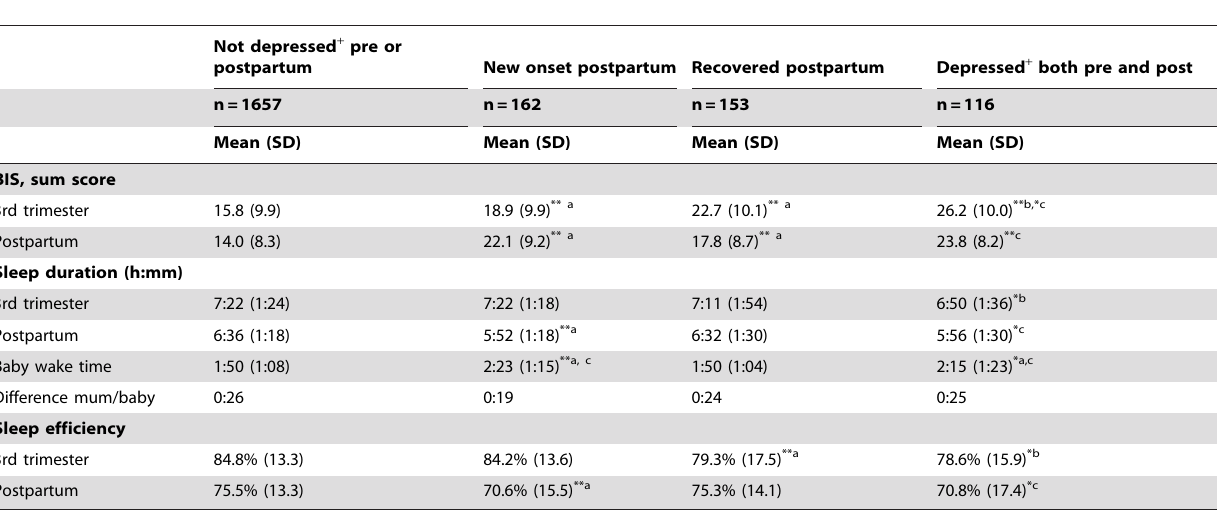
Table 3. Differences in insomnia scores and other sleep parameters according to depressive status + before and after delivery among 2088